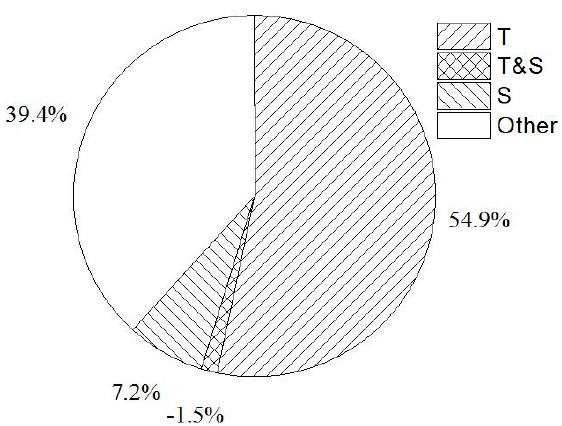
Figure 9. Explanation efficiency of the collaborative effect of both time and space on the water environment variation of the LR, China, 2013–2015.